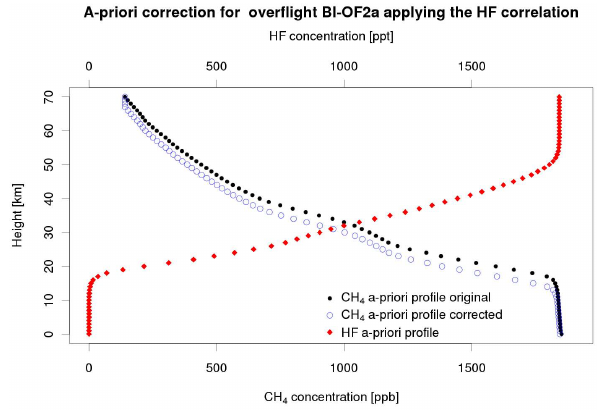
Fig. 4. The effect of applying the CH 4 -HF-correlation to the CH 4 GFIT a-priori profile shown for the example of the overflight BI-